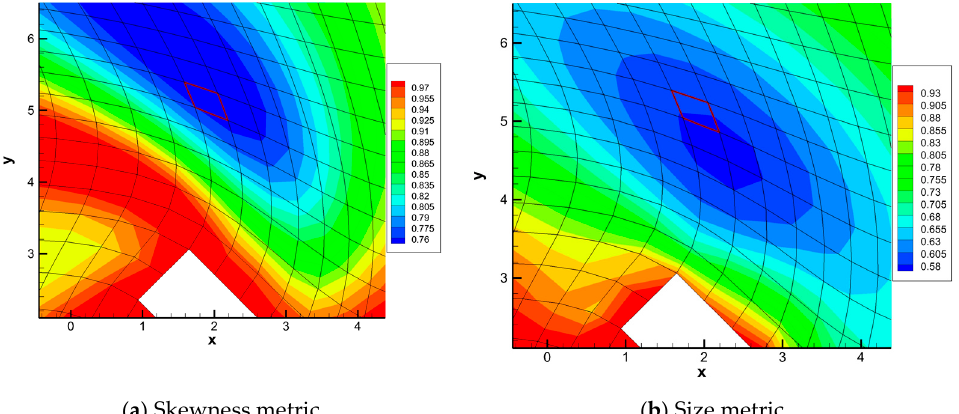
Figure 3. Mapping-based metrics of test case 1.